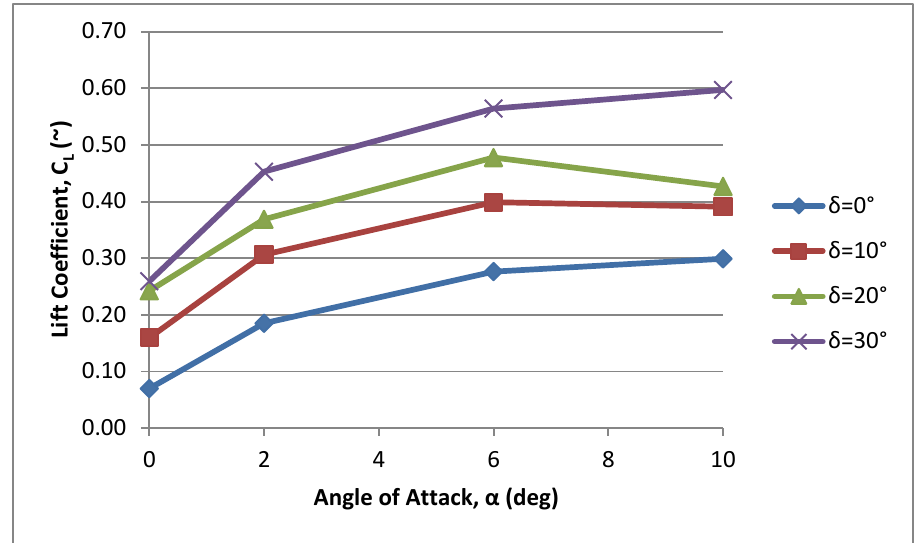
Figure 11. Lift coefficient over angle of attack from wind tunnel